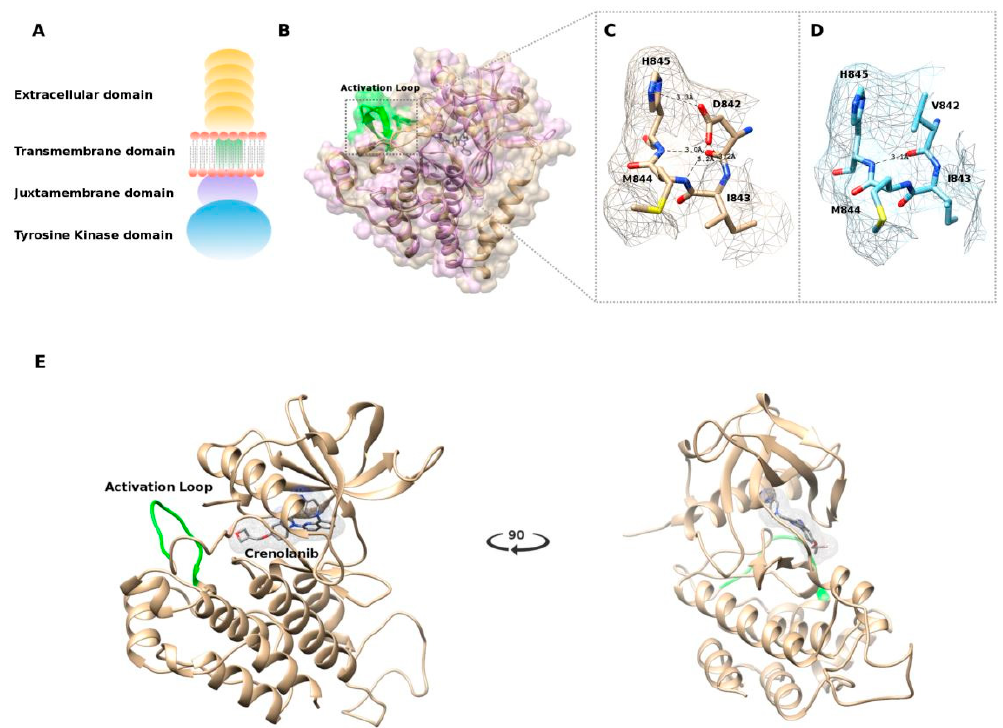
Figure 5. ( A ) Schematic representation of the platelet-derived growth factor receptor alpha (PDGFRA) receptor; ( B ) Structure alignment performed using the jCE algorithm, between the crystallized structure of the c-Kit–Imatinib complex (PDB: 1T46) in purple and the structure of PDGFRA (PDB: 5K5X) in gold. Highlighted in green is the Activation loop; ( C ) Polar interactions of the 842 residue with wild-type Aspartic Acid; ( D ) Polar interactions of the 842 residue carrying the mutated Valine amino acid; ( E ) Representation of the best docked pose of crenolanib in the PDGFRA ATP binding site.